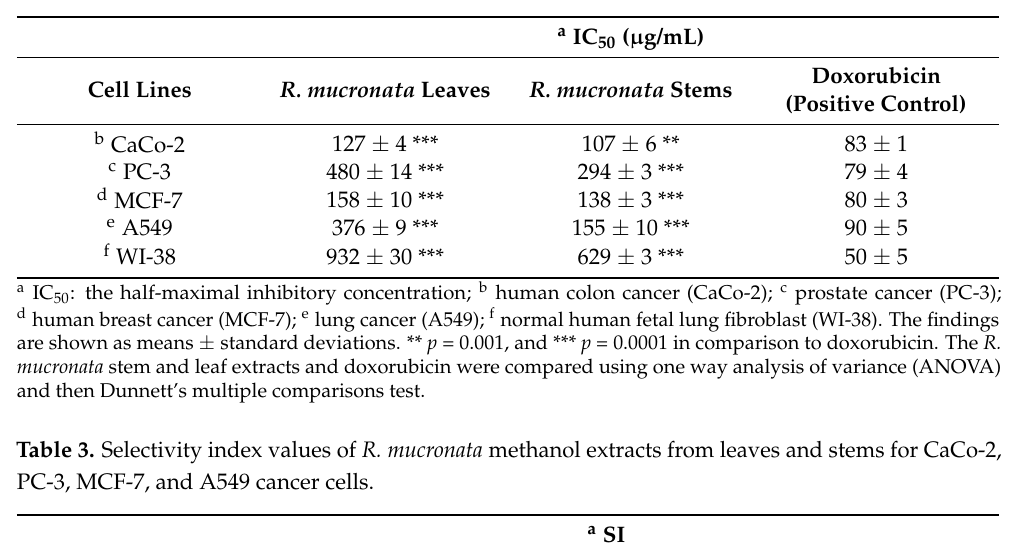
Table 3. Selectivity index values of R. mucronata methanol extracts from leaves and stems for CaCo-2, PC-3, MCF-7, and A549 cancer cells. a SI Extract b CaCo-2 c PC-3 d MCF-7 e A549 Leaves 7.3 2 5.8 2.4 Stems 5.8 2.1 4.5